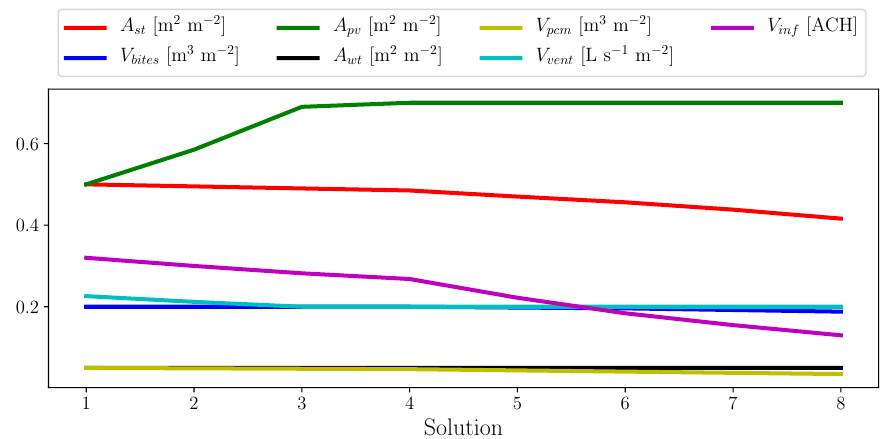
Figure 7. Pareto path of optimization process for design parameters using 2D visualization.